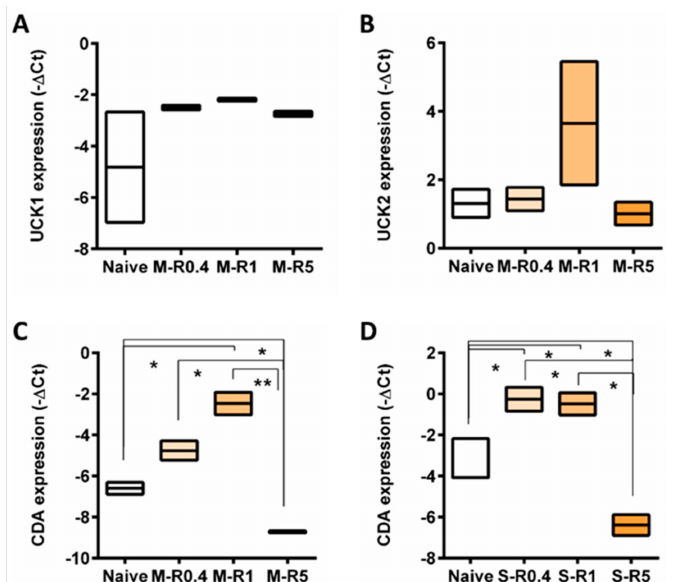
Figure 5. The expression of genes involved in AZA metabolism across naïve and AZA-resistant cell lines. Box plot representing gene expression of ( A ) UCK1 and ( B ) UCK2 in MOLM-13, CDA